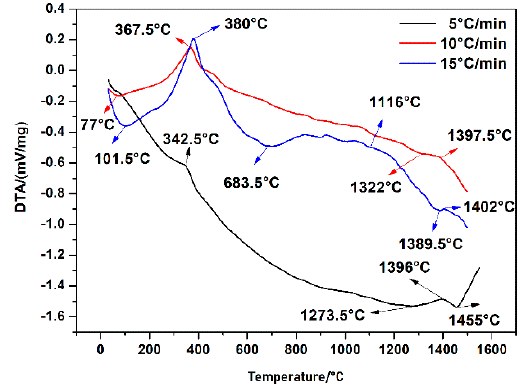
Figure 6. DTA curve of granulation powders under different heating rates.